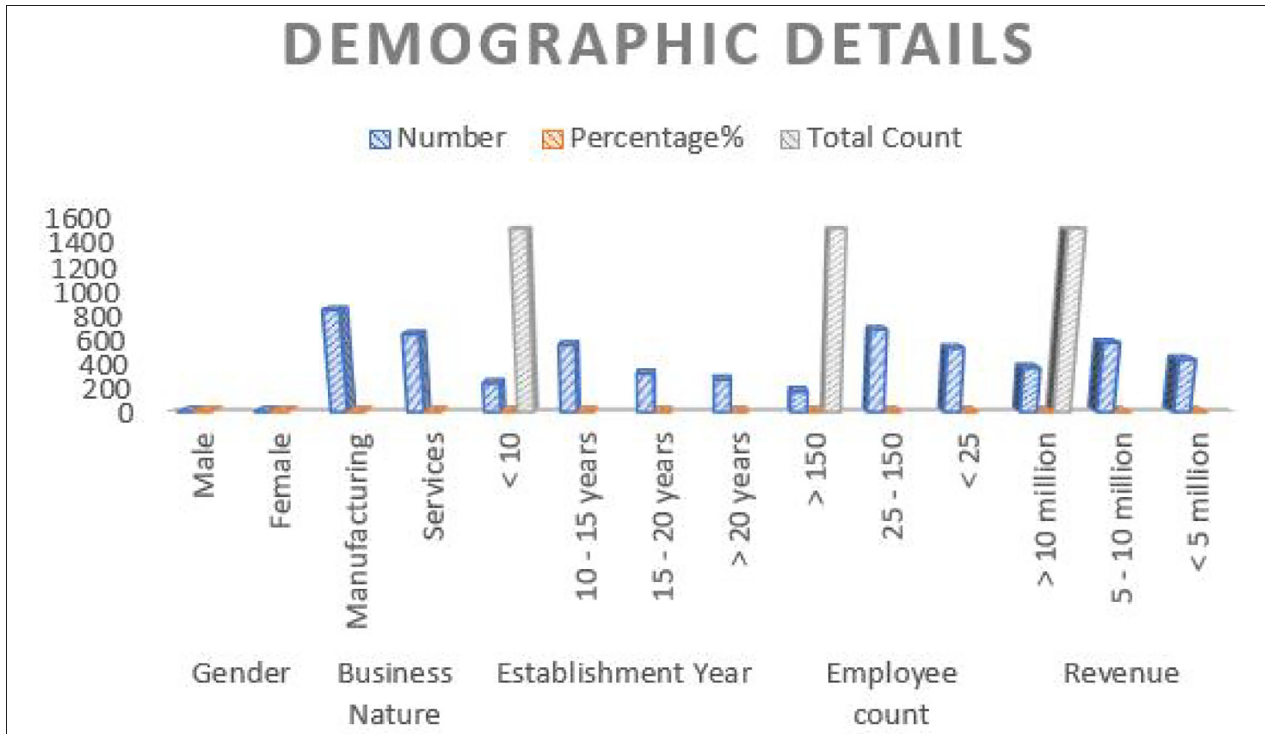
FIGURE 3 | Graphical representation of demographic details ( X -axis, demographic variables; Y -axis, number of respondents).